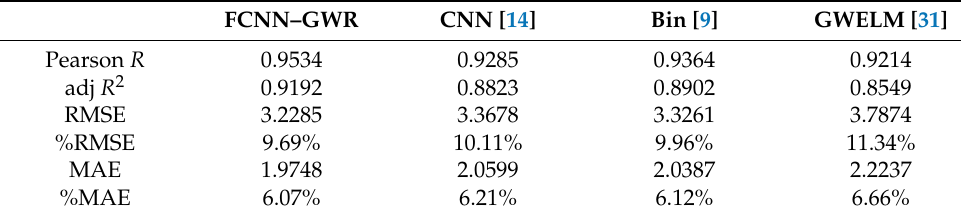
Table 6. Comparison of FCNN–GWR with some previously published models (in Wuhan).